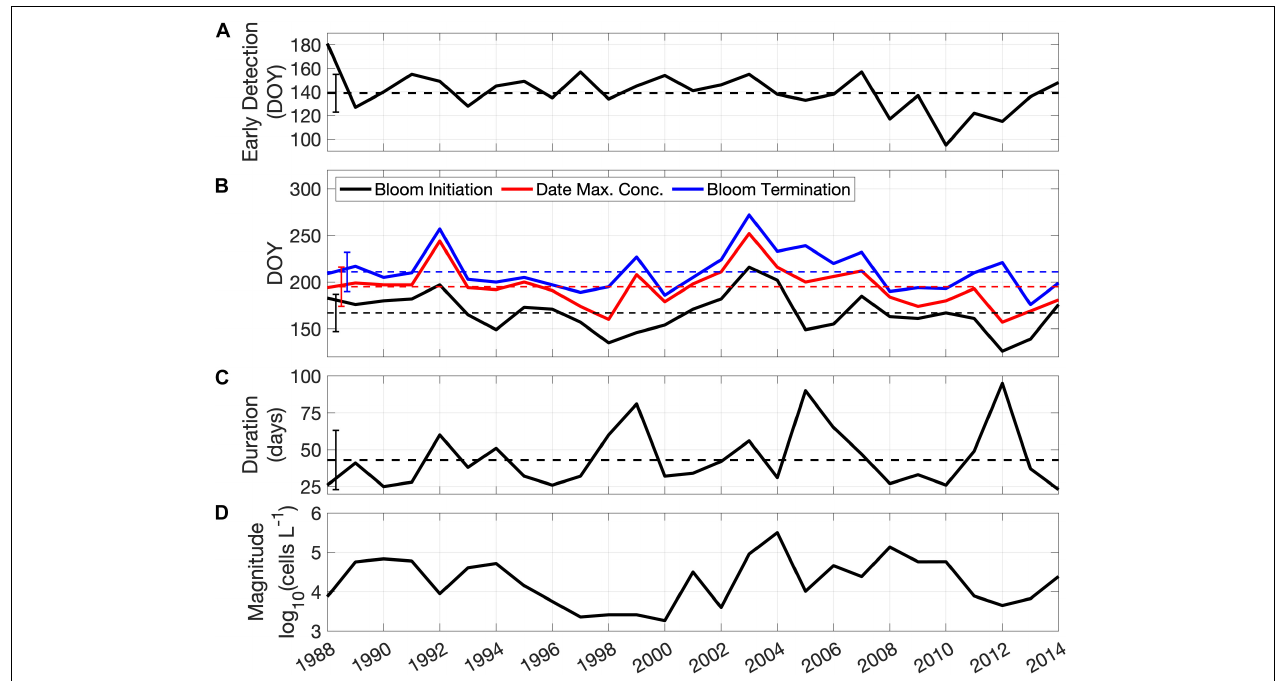
FIGURE 3 | Time series of A. catenella bloom metrics from 1988 to 2014. (A) Early detection dates; (B) bloom initiation dates (black), date of maximum concentration (red), and bloom termination dates (blue); (C) duration (in days); (D) annual maximum concentration of A. catenella (note log 10 scale). Dashed lines in (A–C) represent the mean and the vertical bars on the left are the standard deviation of each metric over the study period.